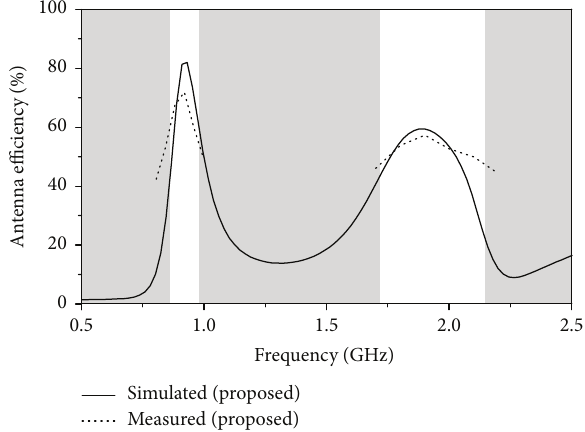
Figure 14: Simulated and measured antenna efficiencies of the optimized mobile antenna (with mismatching loss